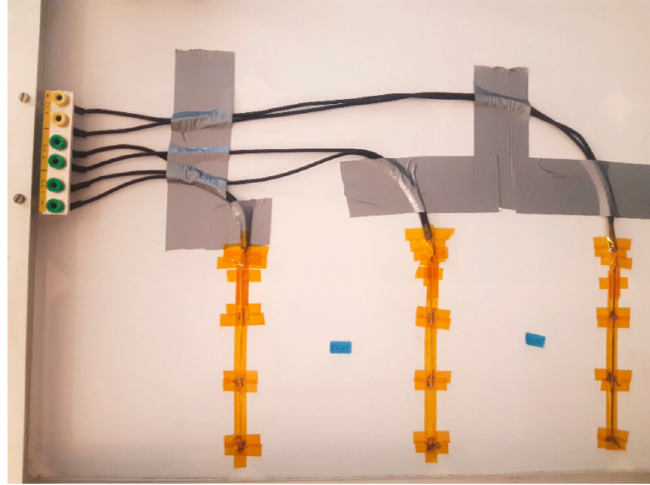
Figure 5. Modification of module for measuring individual cells.